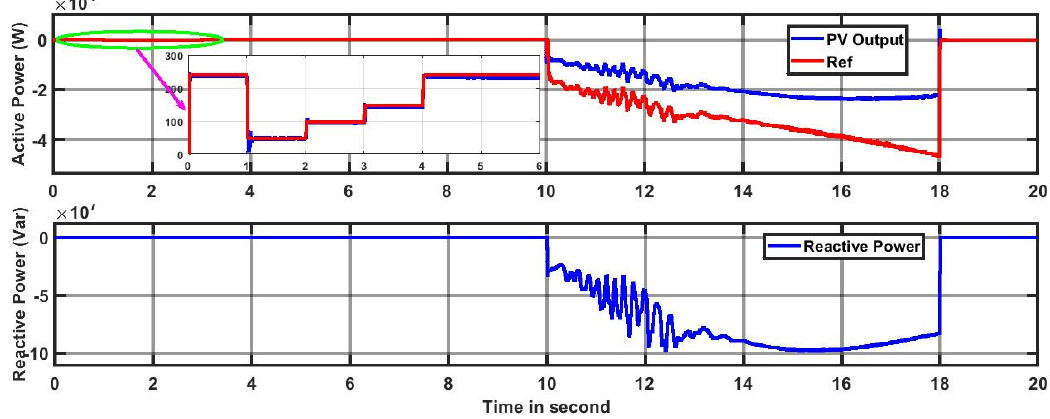
Figure 12. PV active and reactive power outputs.